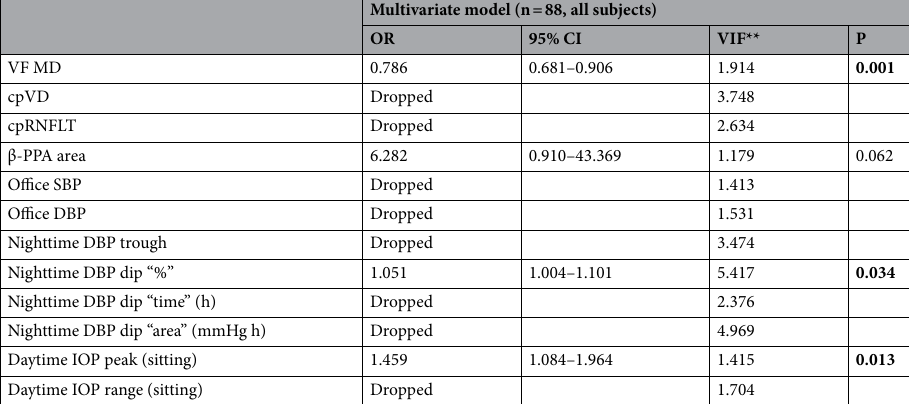
Table 4. Results of multivariate logistic regression analysis for determining the factors associated with presence of choroidal microvasculature dropout in all study subjects. A backward elimination process was used to build a multivariate logistic regression model incorporating variables with P < 0.10 in univariate analysis. Statistically significant differences are shown in bold. OR odds ratio, CI confidence interval, VIF variance inflation factor, VF visual field, MD mean deviation, cpVD circumpapillary vessel density, cpRNFLT circumpapillary retinal nerve fibre layer thickness, β-PPA beta parapapillary atrophy, SBP systolic blood pressure, DBP diastolic blood pressure, IOP intraocular pressure.